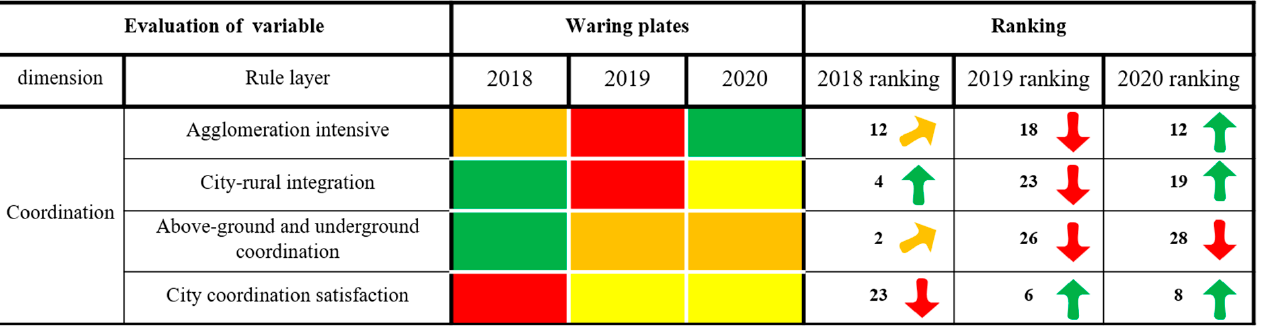
Figure 8. The results of the coordination dimension of city health examination and evaluation in Xining City.